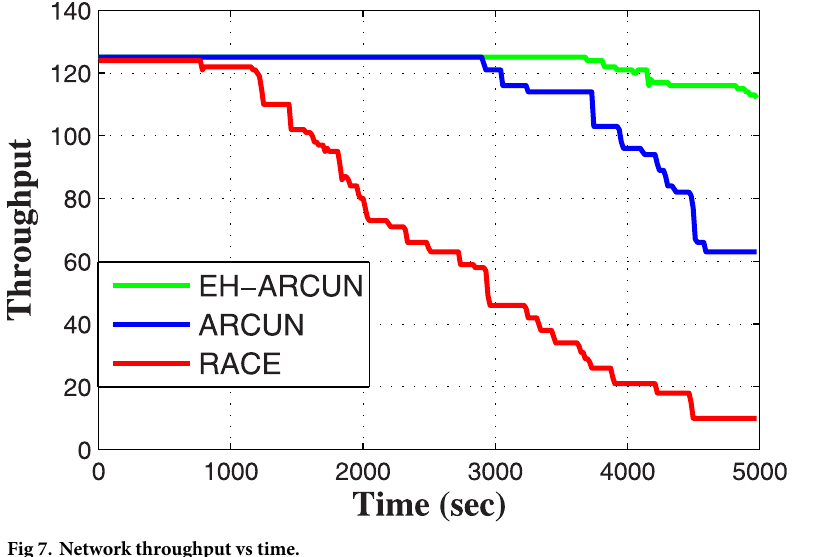
Fig 7. Network throughput vs